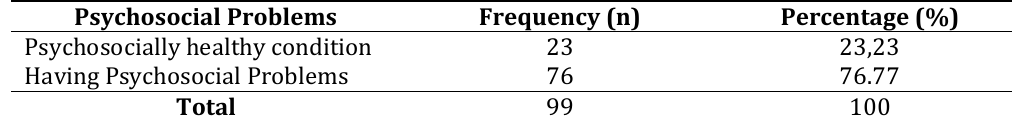
Description of the Psychosocial Problems in Class 2A of Pekalongan Detention Center Psychosocial Problems